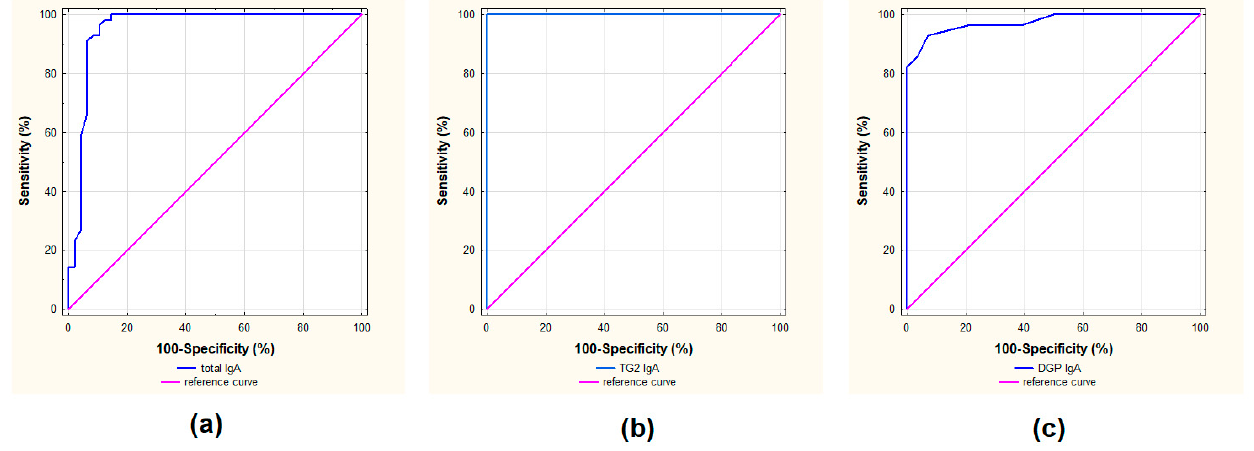
Figure 2. ROC curve and AUC for tIgA ( a ), TG2 IgA ( b ) and DGP IgA ( c ) on the panel Polycheck ® Celiac IgA plus total IgA.